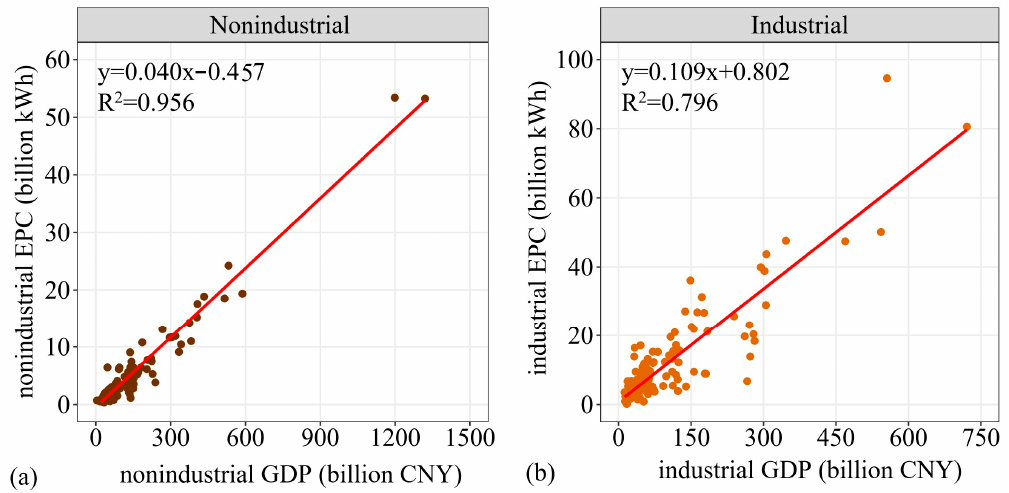
Figure 2. Linear relationship at the prefecture level: ( a ) nonindustrial EPC and GDP; ( b ) industrial EPC and GDP.